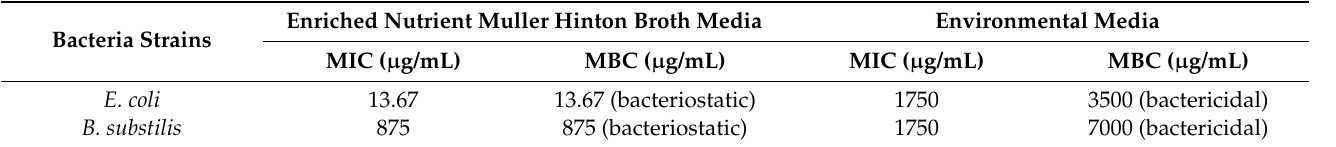
Table 3. Disinfecting ability of the synthesized pMWCNT/CD/TiO 2 -Ag based on the obtained MIC and MBC. Bacteria